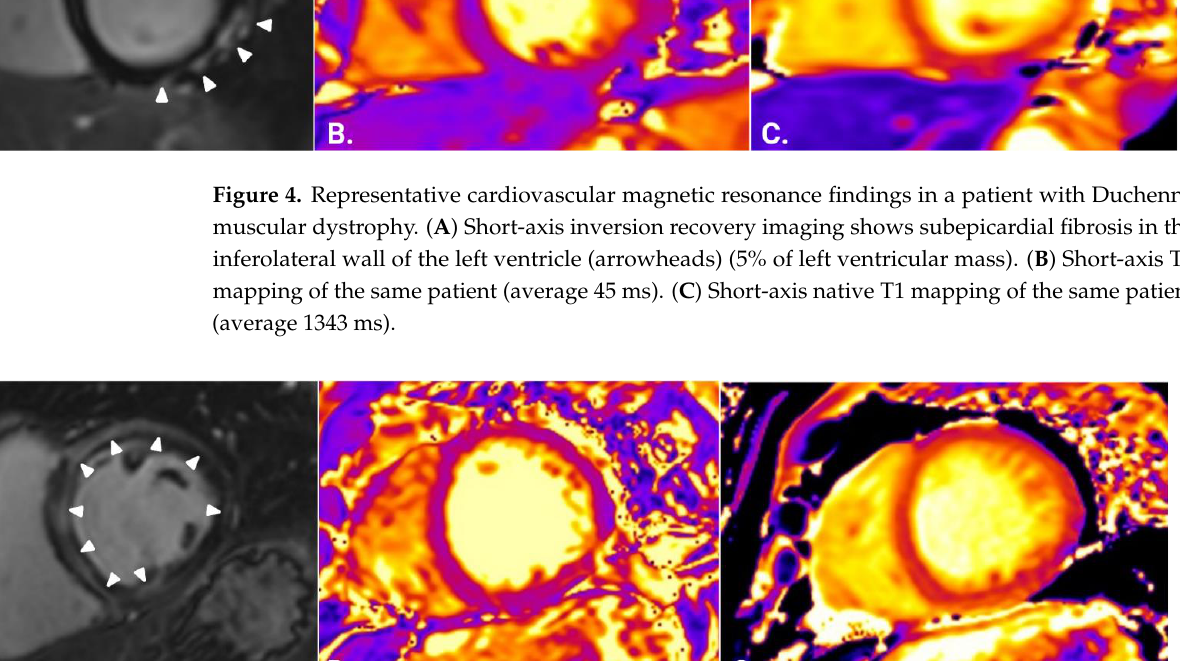
Figure 5. Representative cardiovascular magnetic resonance findings in a patient with polymyositis. ( A ) Short-axis inversion recovery shows extensive diffuse midwall myocardial fibrosis (arrowheads) (17% of left ventricular mass). ( B ) Short-axis T2 mapping of the same patient (average 68 ms). ( C ) Short-axis native T1 mapping of the same patient (average 1300 ms).